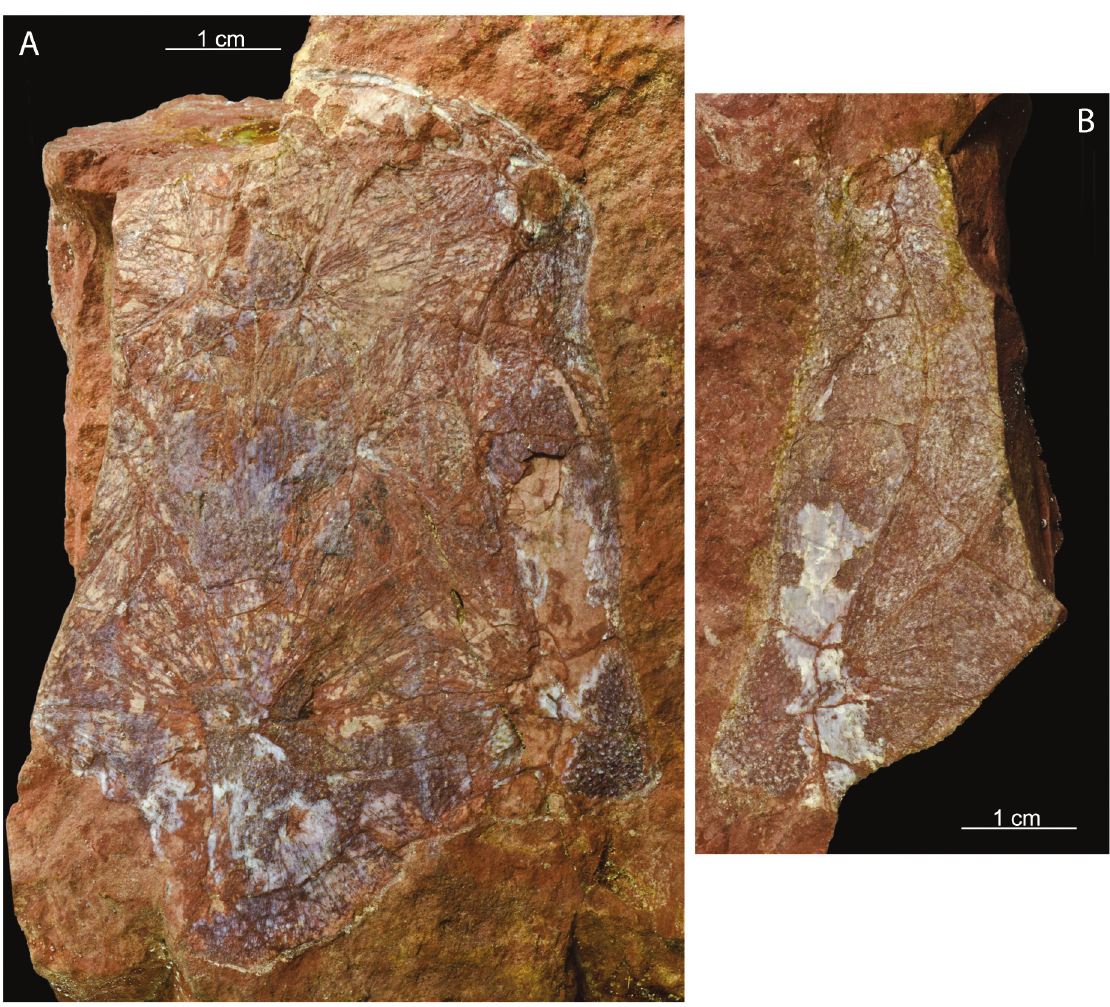
Fig. 2. Eukaia elongata gen. et sp. nov. A , skull roof, dorsal view (GIT 604-4, holotype); B , counterpart of the right side of specimen GIT 604-4. Specimens are photographed under